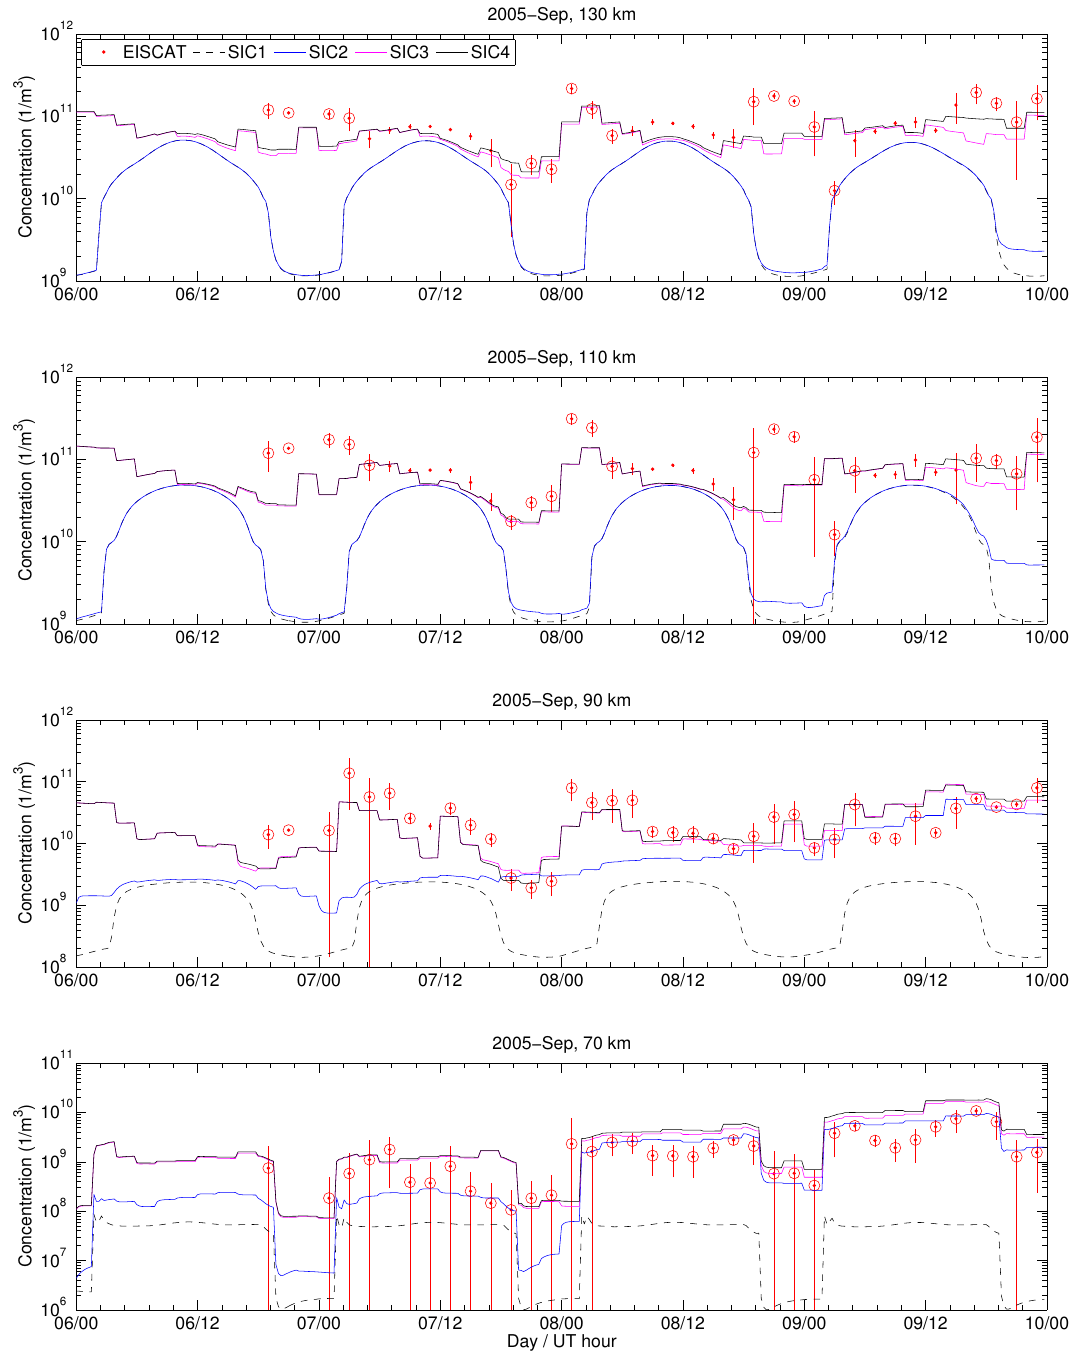
Figure 6. As Fig. 4, but for the September 2005 event (Case